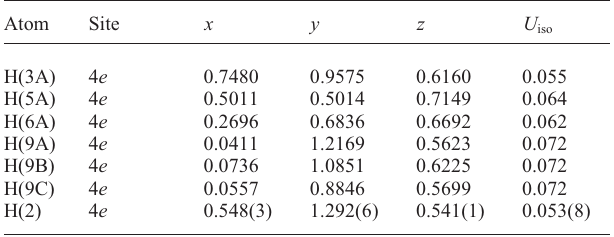
Table 2. Atomic coordinates and displacement parameters (in Å 2 )